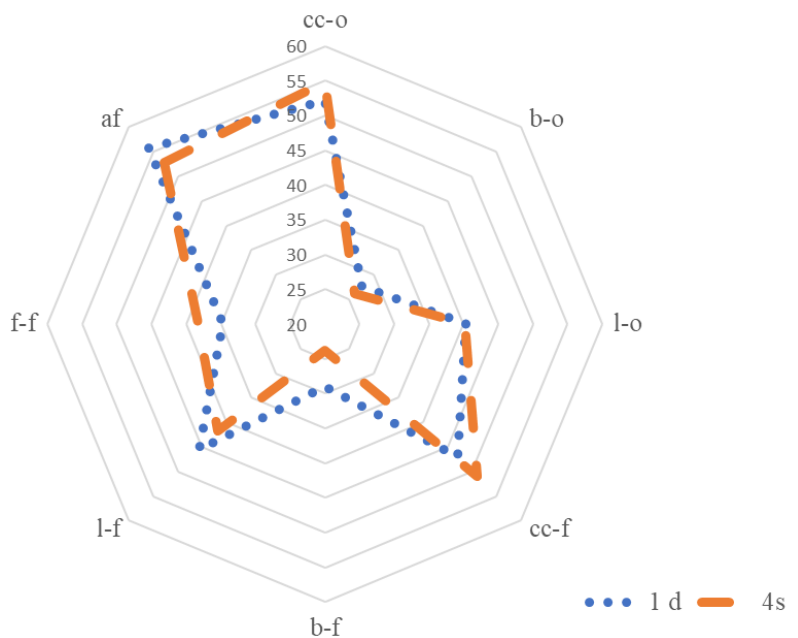
Figure 2. Odour and flavour attributes of the Longissimus thoracis muscle from Navarra breed lambs aged 1 and 4 days (cc-o: characteristic odour; b-o: blood odour; l-o: liver odour; cc-f: characteristic flavour; b-f: blood flavour; l-f: liver flavour; f-f: fatty flavour; af: aftertaste). Scale: 150-mm unstructured hedonic scale, with a mark 10 mm from the left, representing “low intensity” and 10 mm from the right, representing “high intensity”.